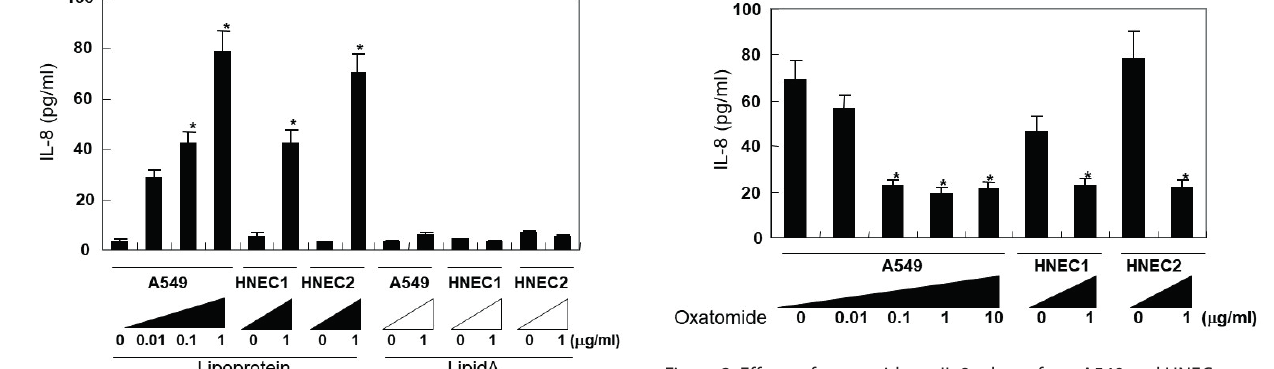
according to the manufacturer’s instructions. Background means ± SD of triplicate samples (34) .